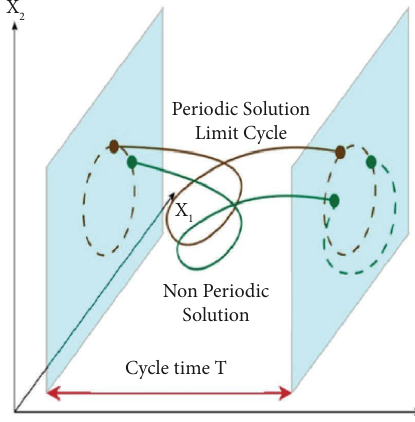
Figure 1: Poincar´e maps.